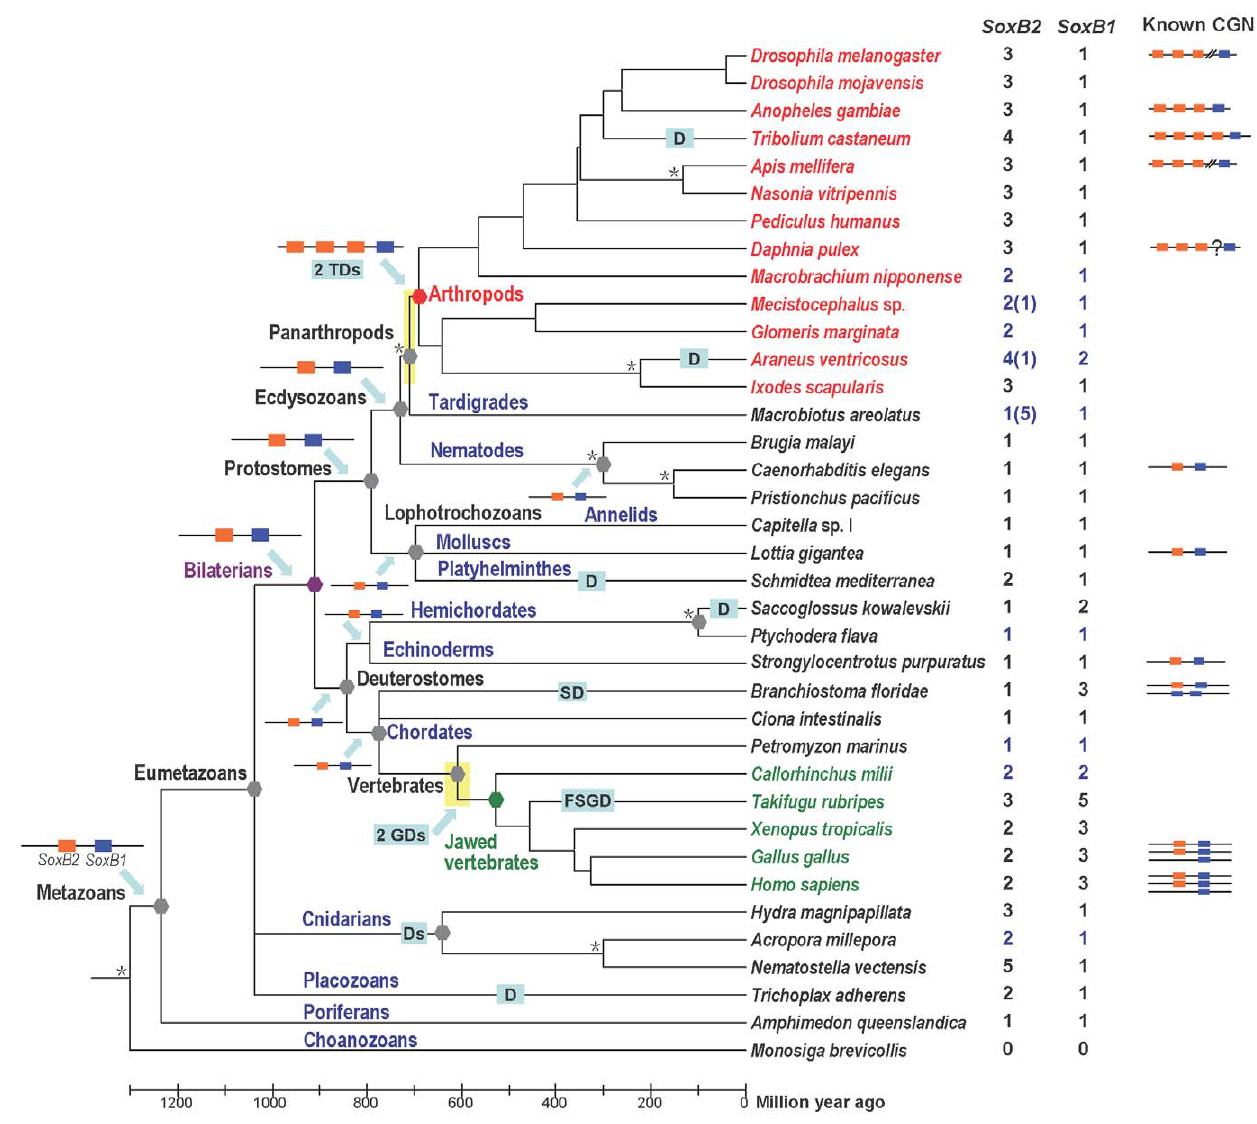
Figure 7. SoxB1/B2 evolution mapped onto the metazoan timetree. The genes of Sox subgroups B1 and B2 are represented by blue and red rectangles, respectively. Numbers on the right side of the tree indicate the estimated inventory of the Sox subgroups B2 and B1 respectively in the taxon. The numbers in black indicate that the inventory estimate for the taxon is based on the comprehensive survey in whole genome sequences; the numbers in blue indicate that the inventory estimate for that taxon is based on heuristic survey; the numerals in parentheses indicate the numbers of genes having ambiguous identities because only incomplete HMG box sequences are available for these genes. The known conserved gene neighborhood (CGN) of the group B Sox genes in species belonging to that taxon are indicated on the right of the taxon name. The line breaks in Drosophila and Apis indicate linkage breaks. The question mark in Daphnia indicates that the linkage between the SoxB2 genes and SoxB1 is not yet determined. The names of phylogenetic groups are indicated beside the nodes or along the terminal branches. The ancestral genomic states of SoxB1/B2 at the major nodes of the metazoan phylogeny are reconstructed on the principle of parsimony and shown beside the nodes. The two yellow blocks over phylogenetic nodes indicate the range of the phylogenetic timing of the duplication events. The asterisks beside phylogenetic nodes indicate that the timing of the nodes is arbitrary due to lack of information. Abbreviations in rectangles: D, duplication; FSGD, fish-specific genome duplication; GD, genome duplication; SD, segmental duplication; TD, tandem gene